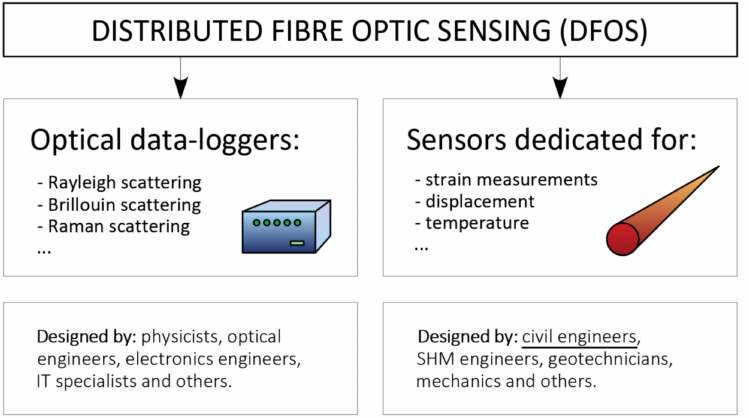
Figure 2. Scheme of distributed fibre optic sensing (DFOS) components within civil